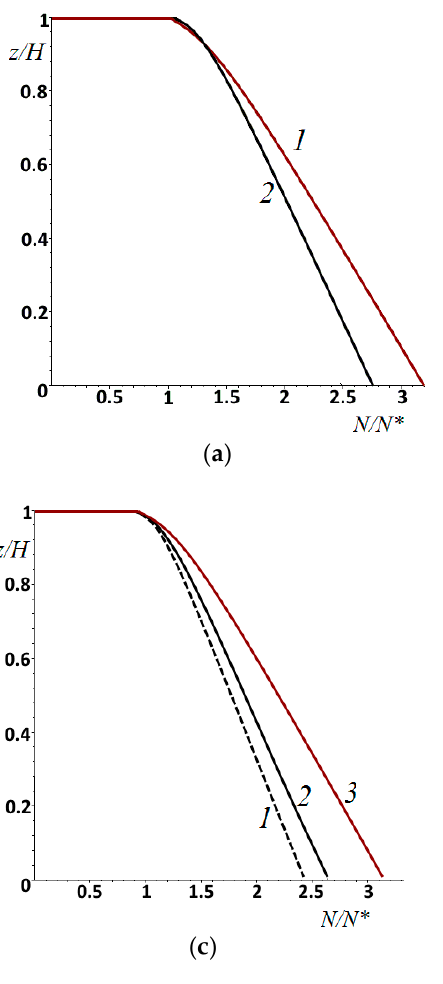
Figure 7. Displacement of the layer surface (wear kinetics). Effect of sliding velocity ( a ): V (cid:48) = 0.0208 (curve 1) or V (cid:48) = 0.0625 (curve 2), µ = 0, c = 5. Effect of friction ( b ): µ = 0 (curve 1) or µ = 0.3 (curve 2), V (cid:48) = 0.0625, c = 5. Effect of parameter c ( c ): c = 2, 5, or 10 (curves 1–3, respectively), µ = 0 (curve 2), V (cid:48) = 0.0208. ν = 0.4, p n (cid:48) = 4.2 · 10 − 2 , h (cid:48) = n